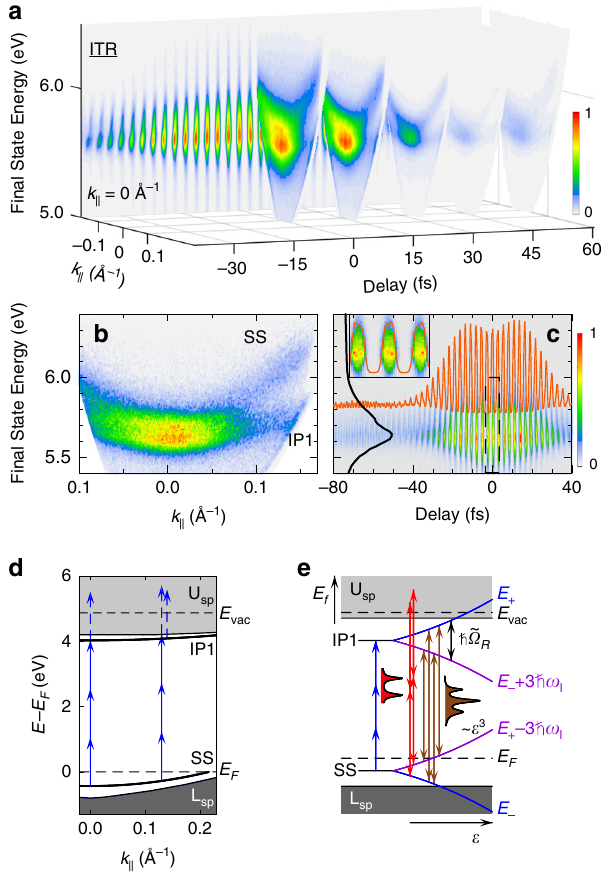
Fig. 1 Coherent photoelectron spectroscopy of optical dressing. a Three- dimensional ITR-4PP movie of the three-photon resonant IP1 ← SS transition ( ħ ω l = 1.54 eV). Each frame of Supplementary Movie 1, from which the data is taken, records the photoelectron signal counts vs. E f (relative to the Fermi level, E F ), and k || in ~100 as steps (sample movie frames are shown in 15 fs intervals). The back panel shows a cross section through the movie for k || = 0 Å − 1 . b Time-integrated 4PP spectrum showing the SS and IP1 bands for resonant excitation at k || = 0 Å − 1 . c Selection of data from a for k || = 0 Å − 1 showing an E f ( τ )- interferogram; the pro fi les show I2PC trace for E f = 5.65 eV (orange) and a 4PP spectrum for τ = 0 fs (black); the inset expands the E f ( τ )-data around τ = 0 fs (the dashed box). The dressing is evident in the dip in I2PC intensity at τ = 0 fs that is caused by the subfemtosecond splitting of the interference fringes, when the pump and probe fi elds are in-phase and E ( τ ) is maximum, but not in the τ = 0 fs E f -pro fi le. d The unperturbed surface-projected band structure of Cu(111). The SS and IP1 bands (black lines) in the surface-projected band gap between the lower and upper sp - bands, L sp and U sp (gray shading), are coupled by the three-photon resonant laser fi eld (blue); the fourth photon induces the photoemission (dashed blue). The excitation is resonant at k || = 0 Å − 1 producing one peak with enhanced 4PP yield in b ; the different m eff of the SS and IP1 bands, however, cause their detuning for increasing k || and consequent detection of two bands. e The optical dressing of the SS and IP1 bands: the increasing electric fi eld E (right arrow) causes AC Stark effect shifts of the SS and IP1 bands to E ± (blue), while the Floquet effect replicates E ± at integer multiples of n ħ ω l are (violet). The optical dressing is revealed by Mollow-Triplet structures in the resonant coherent polarizations at 3 ω l (brown arrows), and Autler – Townes doublets in the nonresonant coherent polarizations at 2 ω l (red